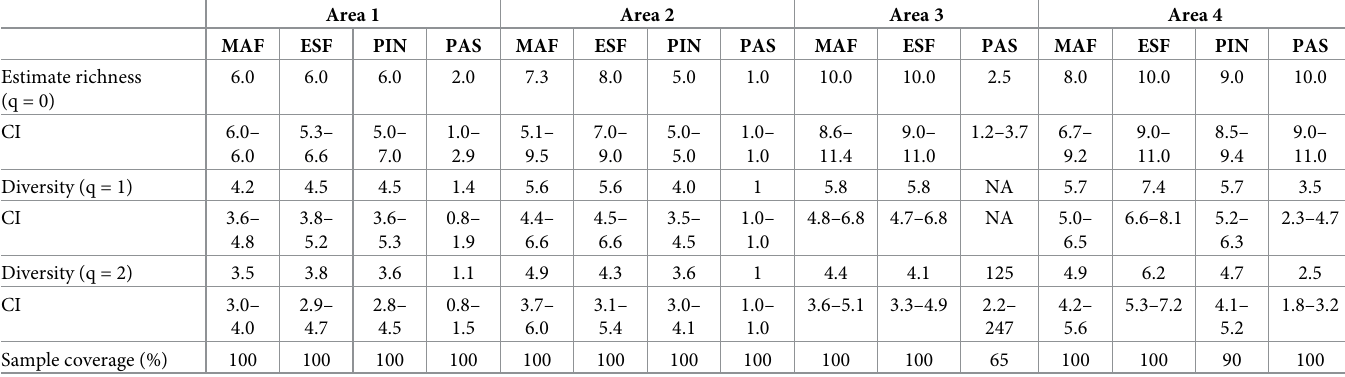
Table 4. Functional diversity based on Hill